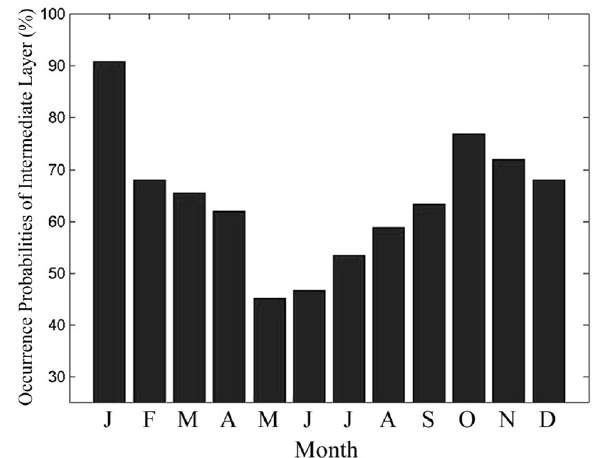
Fig. 2. Monthly variations in occurrence probability of the inter- mediate layers at the observation site throughout 1996. The highest occurrence probability (90%) occurs in January, while the lowest value appears in